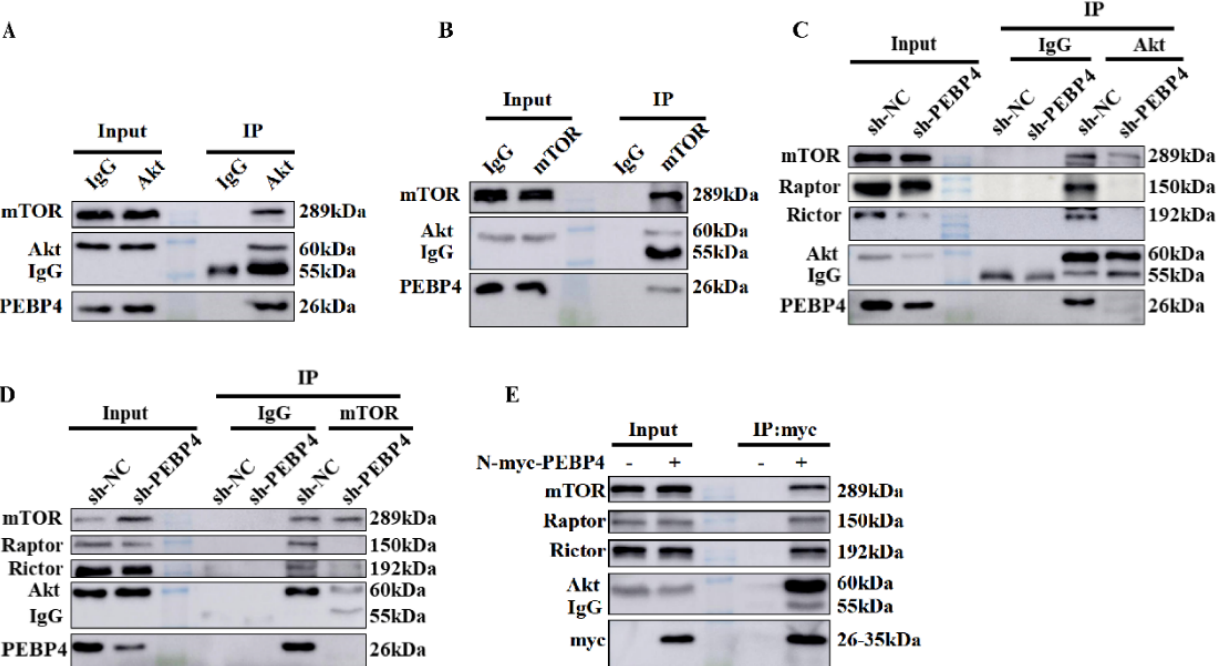
Figure 3. PEBP4 interacts Akt and mTOR. ( A , B ) Extracts of MHCC97H cells were immunoprecipated with anti-Akt antibodies ( A ) or anti-mTOR ( B ) antibodies and blotted with antibodies as indicated. ( C , D ) Extracts of MHCC97H/sh-PEBP4 and MHCC97H/sh-NC cells were immunoprecipitated with anti-Akt ( C ) or anti-mTOR antibodies ( D ), followed by WB. ( E ) HEK293T cells were transiently transfected with plasmid encoding PEBP4 aminoterminally tagged with myc epitope (N-myc-PEBP4) and the recombinant PEBP4 was immunoprecipitated by anti-myc antibody, followed by WB.